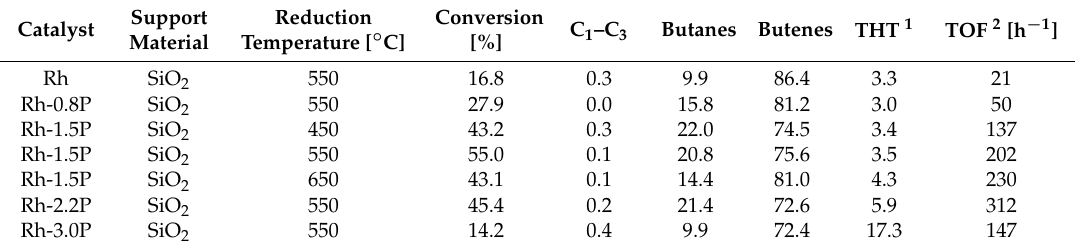
Table 8. Effect of the P loading and reduction temperature on the performance of the Rh 2 P/SiO 2 catalysts on the HDS of thiophene (fixed-bed reactor, 0.1 g catalyst, 350 ◦ C, 0.1 MPa, H 2 /thiophene = 30, W/F = 37.9 g h mol − 1 )